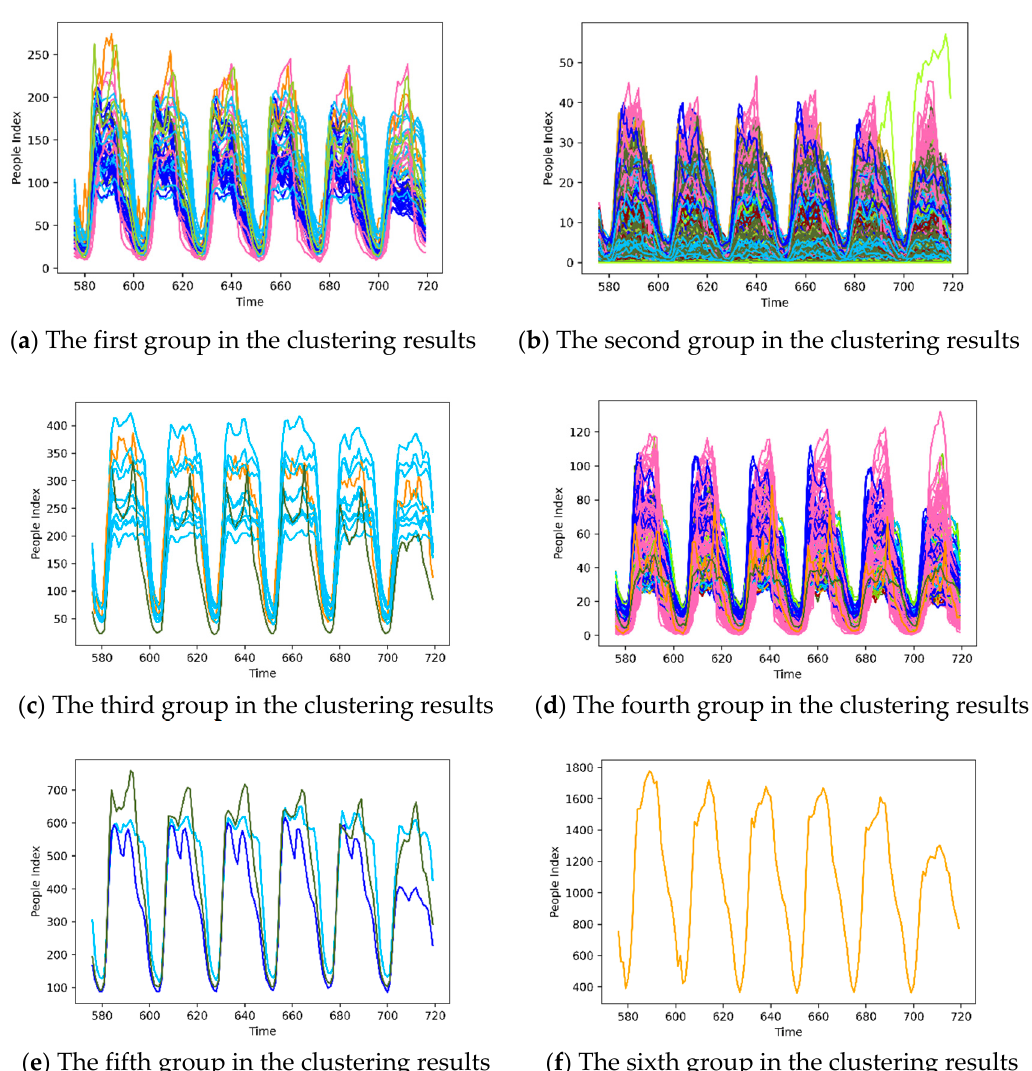
Figure 10. Clustering results of six patterns of changes in pedestrian flow at Beijing hotspot locations during the preliminary resumption of work.